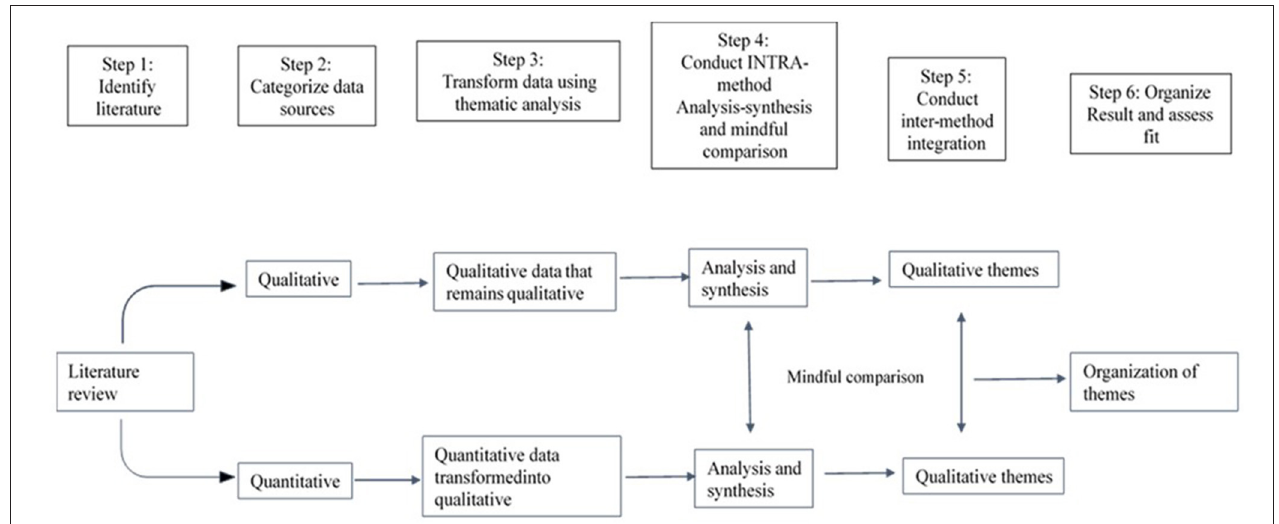
FIGURE 2 | Steps of basic convergent qualitative meta